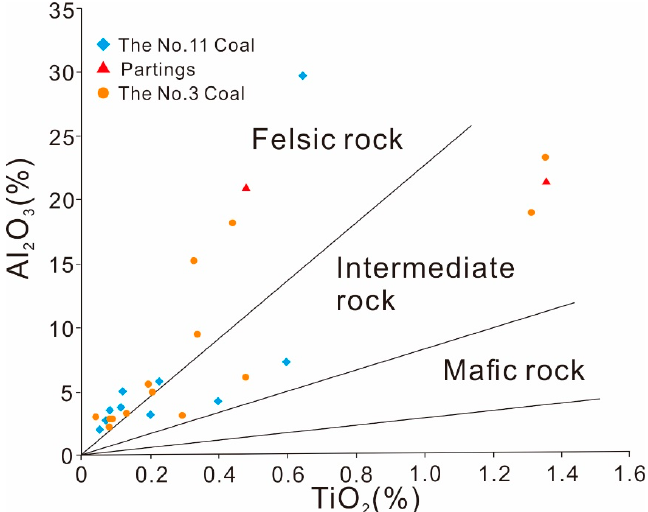
Figure 9. Plots of Al 2 O 3 versus TiO 2 for samples from the No. 11 and No. 3 coal seams, Sangshuping mine, Weibei coalfield. mine, Weibei coalfield.